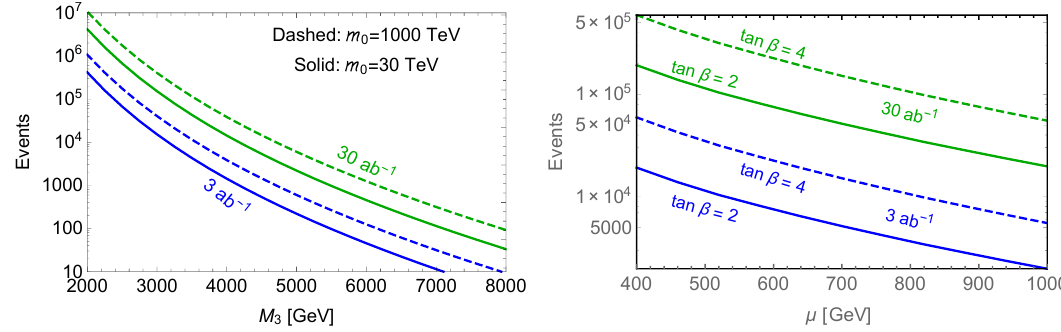
Figure 14 . Number of expected events as a function of mass. Left: gluino pair production events containing a two-body e g ! g e H 0 decay. Solid and dashed lines are obtained by varying the scalar mass from 30 TeV to 1000 TeV. Right: higgsino pair production events, pp ! e H 0 higgsinos decay to Z + e B 0 . (No assumption is made about how the Z decays.) Solid and dashed lines are tan (cid:12) = 2 and tan (cid:12) = 4. In this plot we have (cid:12)xed M 2 = 1 : 5 TeV (rather than 800 GeV as in our benchmark) so that we remain in the higgsino NLSP regime